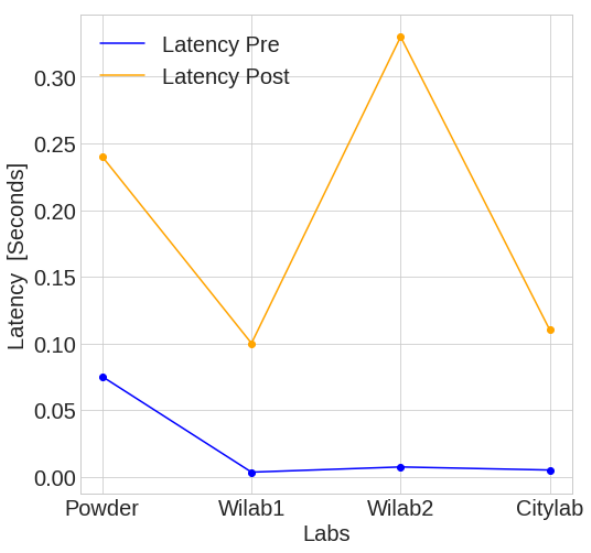
Figure 34. Pre- and post-latency of